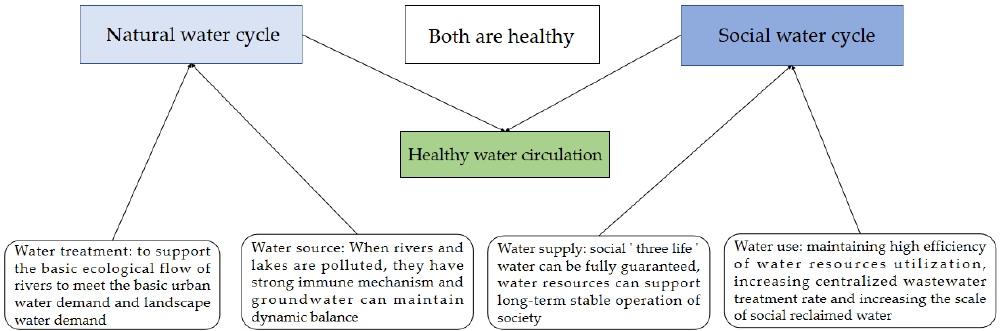
Figure 2. Schematic diagram of urban water cycle health.